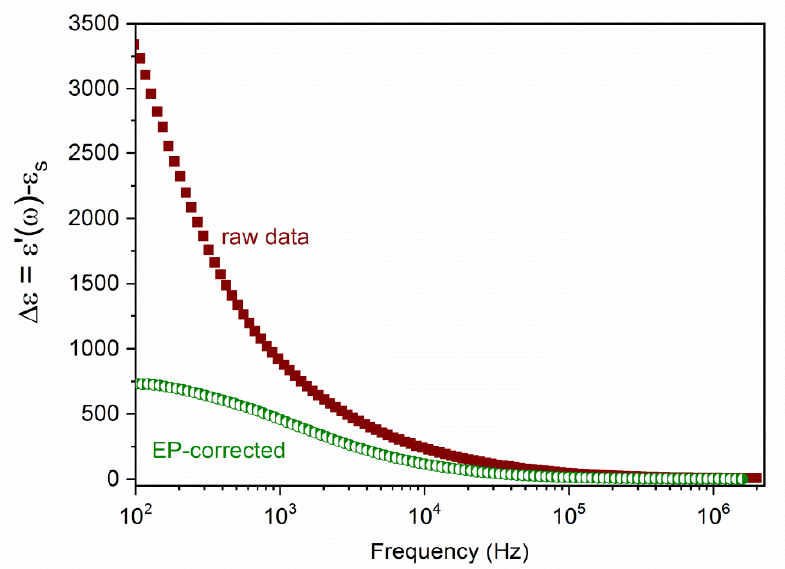
Figure 2. Dielectric increment (real part of the relative permittivity minus the solvent dielectric constant) as a function of frequency for untreated data (“raw”) and data corrected for electrode polarization (EP-corrected) by the logarithmic derivative method. System: 3.3% PS / PDADMAC / PSS / PDADMAC in water.